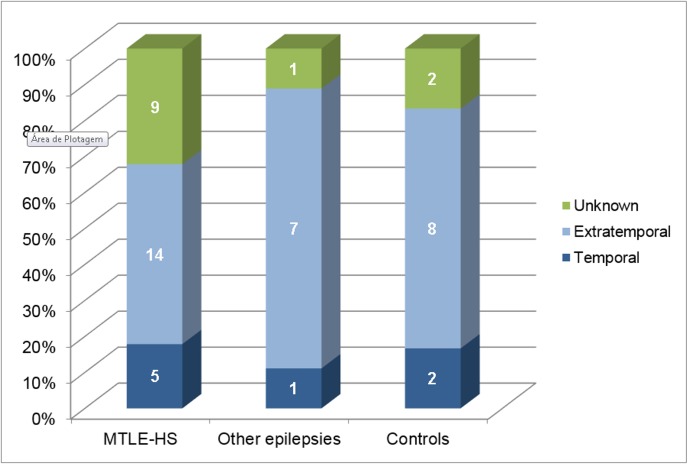
Location of neurocisticercotic calcifications in each group.This graph shows the percentage of subjects with calcifications located in the temporal lobe (Temporal), outside the temporal lobe (extratemporal) and unknown in each subgroups (MTLE-HS, other epilepsies, disease controls). There were no significant group differences considering the presence of calcifications in the temporal lobes. (p = 0.58) MTLE-HS = Mesial temporal lobe epilepsy with hippocampal sclerosis.